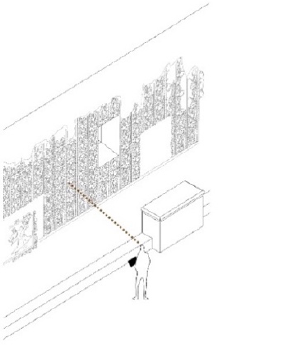
Figure 14 . Scenario 1: Visual documentation. Image by CIMS © GCI 2019.